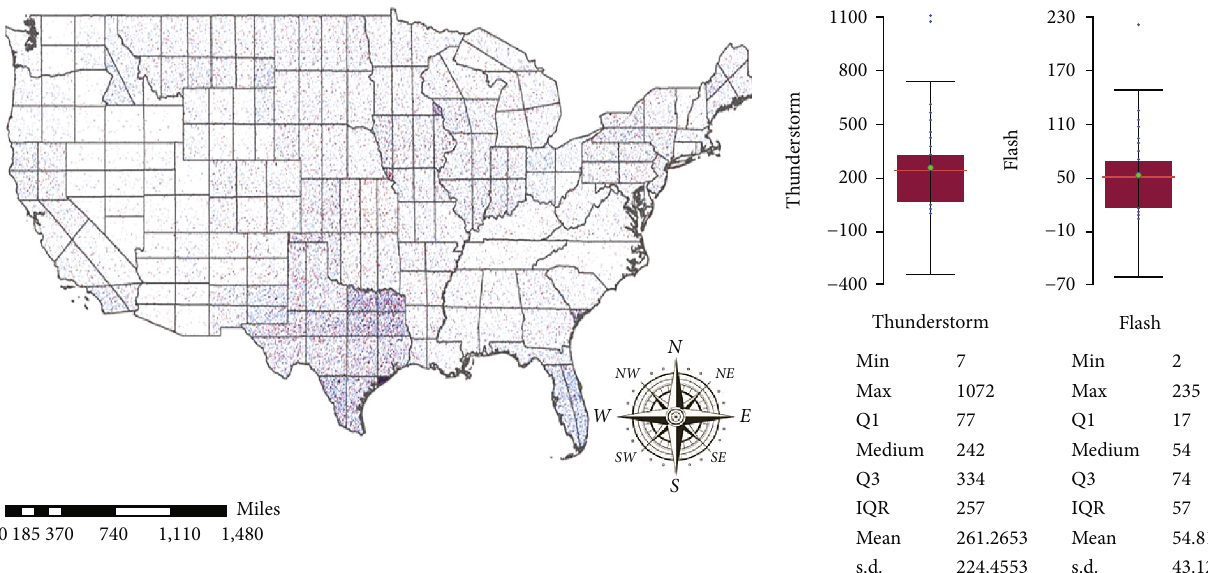
Figure 5: Thunderstorm wind and fl ash fl ood event correlation diagram.